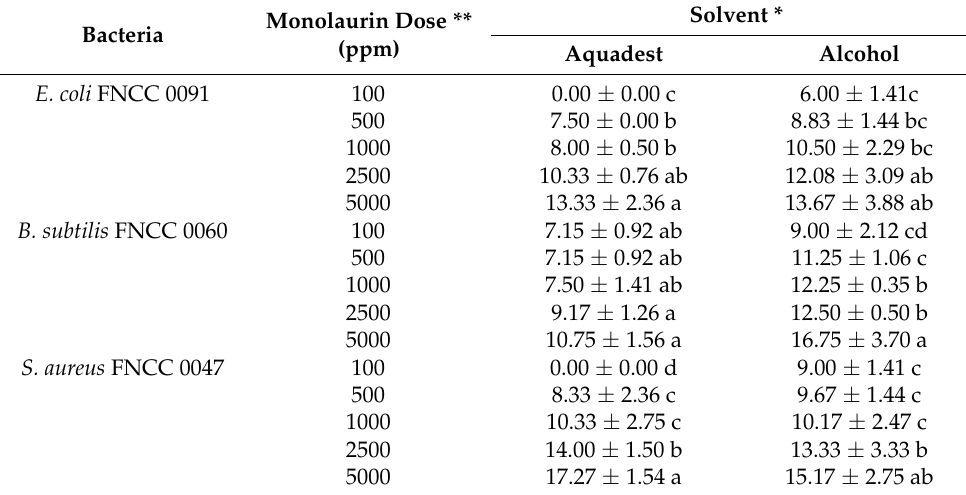
Table 2. Inhibition zone of monolaurin from PKOo-PKS blend on E. coli FNCC 0091, S.